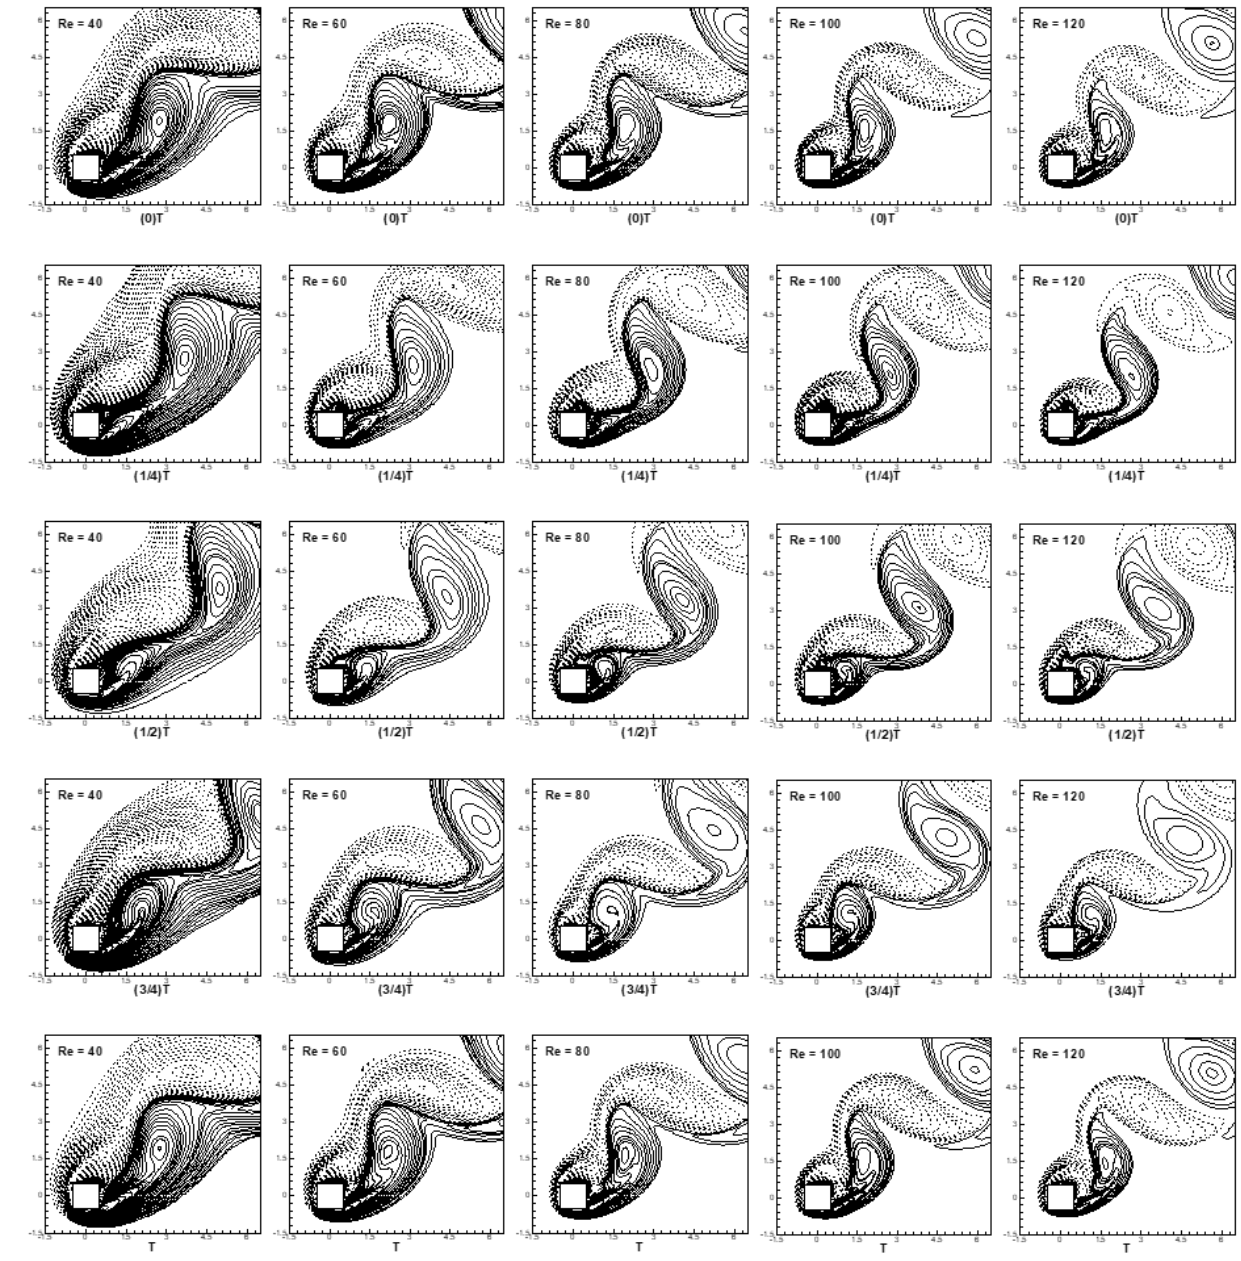
Figure 4. Instantaneous contours of vorticity for the conditions (α = 45 °, Ri = 0 and 40 ≤ Re ≤ 120) for five successive moments of time that span the whole period.